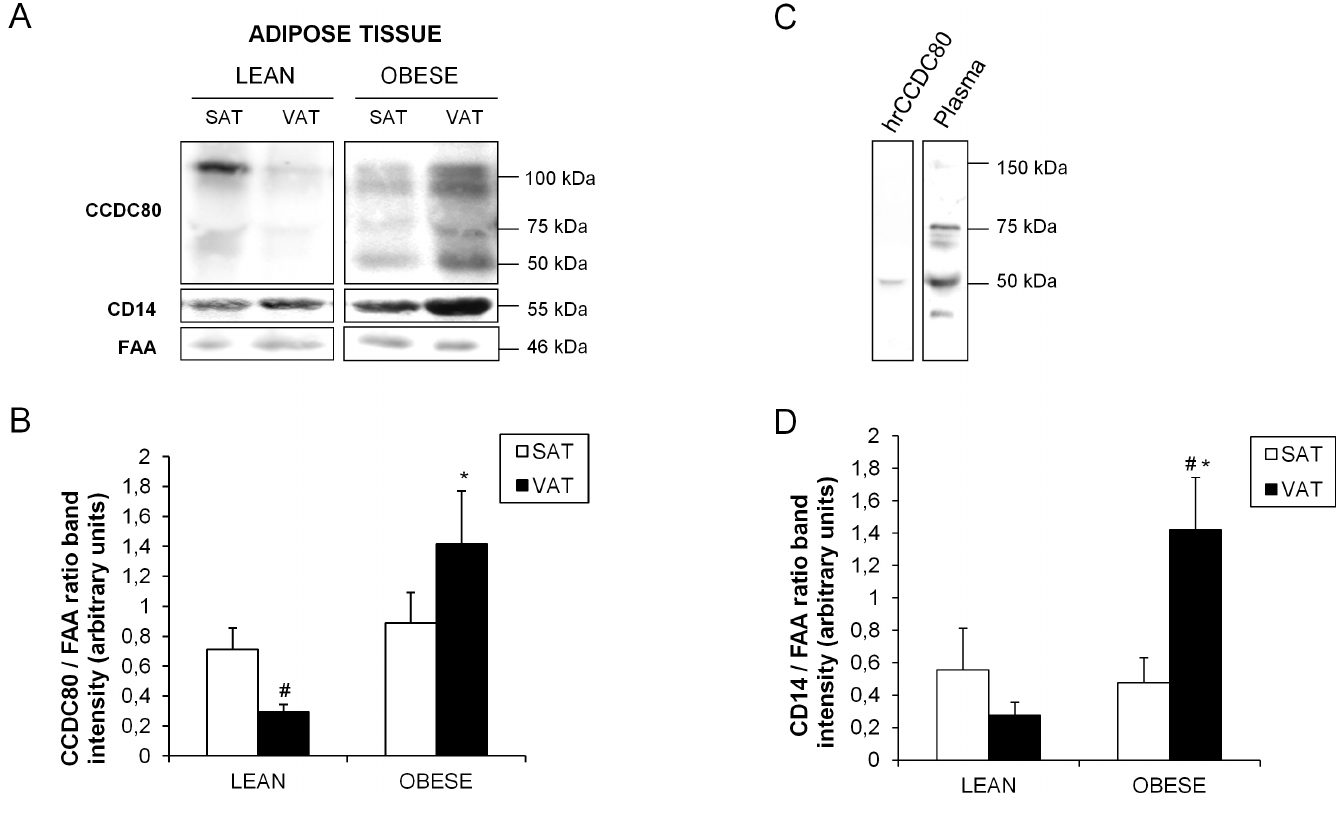
Figure 1. Analysis of CCDC80 and CD14 protein content in SAT and VAT depots from lean and obese patients and CCDC80 protein in human plasma. (A) Western blot analysis of SAT and VAT extracts (20 μ g protein). Membranes were hybridized with antibodies against CCDC80, CD14 and FAA. A representative blot is shown. Bands were quantified and the ratio of intensities between CCDC80 or CD14 and control FAA was calculated. (B) Relative CCDC80 protein content. Data are expressed in arbitrary units and are means ± SEM from 5 samples. # P < 0.05 between different depots in lean patients; * P < 0.05 between VAT depots in obese versus lean patients. (C) Western blot analysis of 1 μ l of human plasma and 0.8 ng of purified CCDC80 protein (50 kDa fragment). The membrane was hybridized with an antibody against CCDC80. (D) Relative CD14 protein content. Data are expressed in arbitrary units and are means ± SEM from 5 sam- ples. # P < 0.05 between different depots in obese patients; * P < 0.05 between VAT depots in obese versus lean